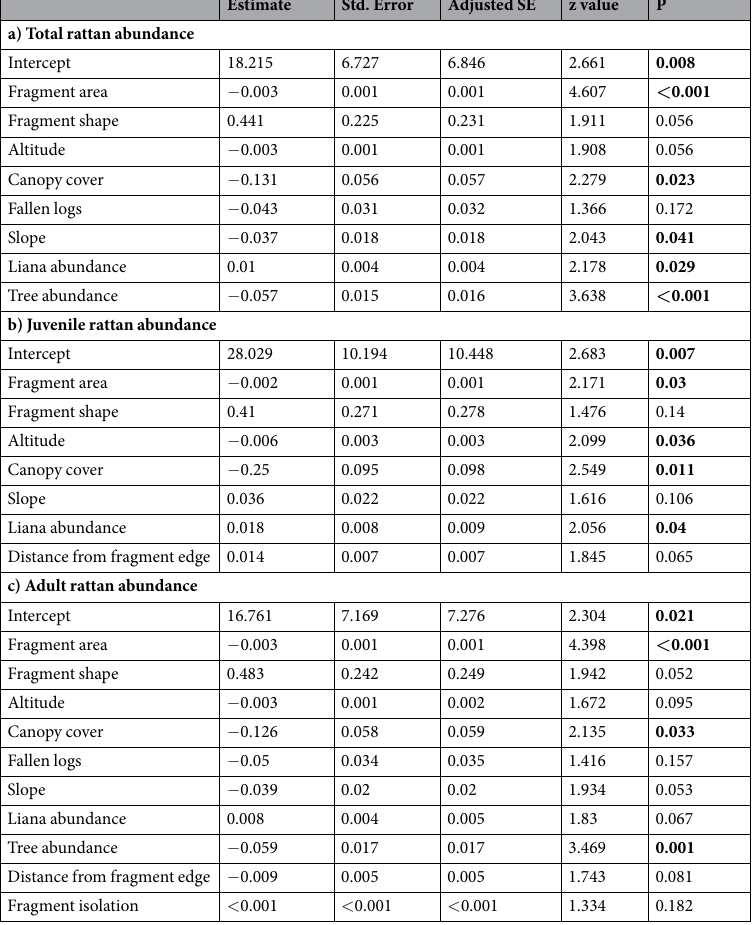
Table 3. Results of model averaged, generalized linear mixed models (negative binomial) examining forest fragments (within fragmented forests only). Response of (a) total rattan abundance, (b) juvenile rattan abundance ( ≤ 3 m long) and (c) adult rattan abundance ( > 3 m in length) to forest fragmentation and environmental